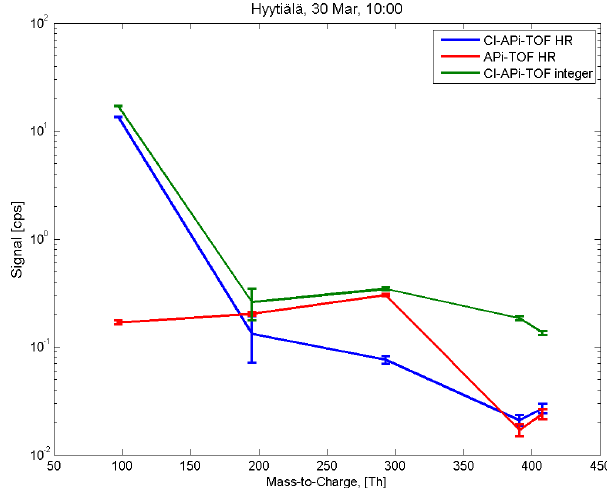
Figure 4. Total sulphuric acid and cluster high resolution (HR) signals (blue, CI-APi-TOF HR), the contribution of naturally charged ions to the total signal (red, APi-TOF) and CI-APi-TOF integer mass signals (green, CI-APi-TOF integer) are present in this figure. Mass-to-charge ratios in the picture correspond to sulphuric acid monomer (97 Th), dimer (195 Th), trimer (293 Th), tetramer (391 Th) and sulphuric acid tetramer-ammonia cluster (408 Th). Error is calculated using counting statistics. It should be noted that the tetramer CI-APi-TOF values represent an upper limit due to overlapping signals (see text and figure 2). Neutral sulphuric acid monomer is the only compound to clearly being charged in the CI-APi-TOF.